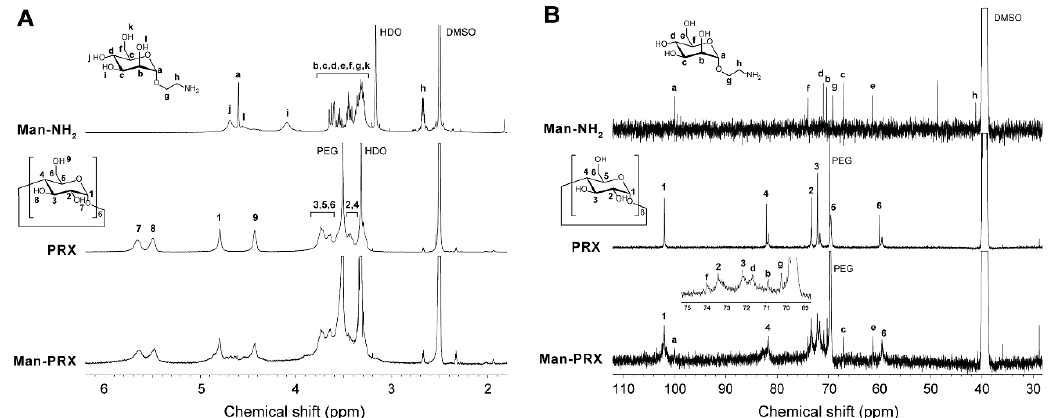
Figure 3. ( A ) 1 H NMR and ( B ) 13 C NMR spectra of Man-NH 2 , unmodified PRX, and Man-PRX in DMSO- d 6 at 25 °C.